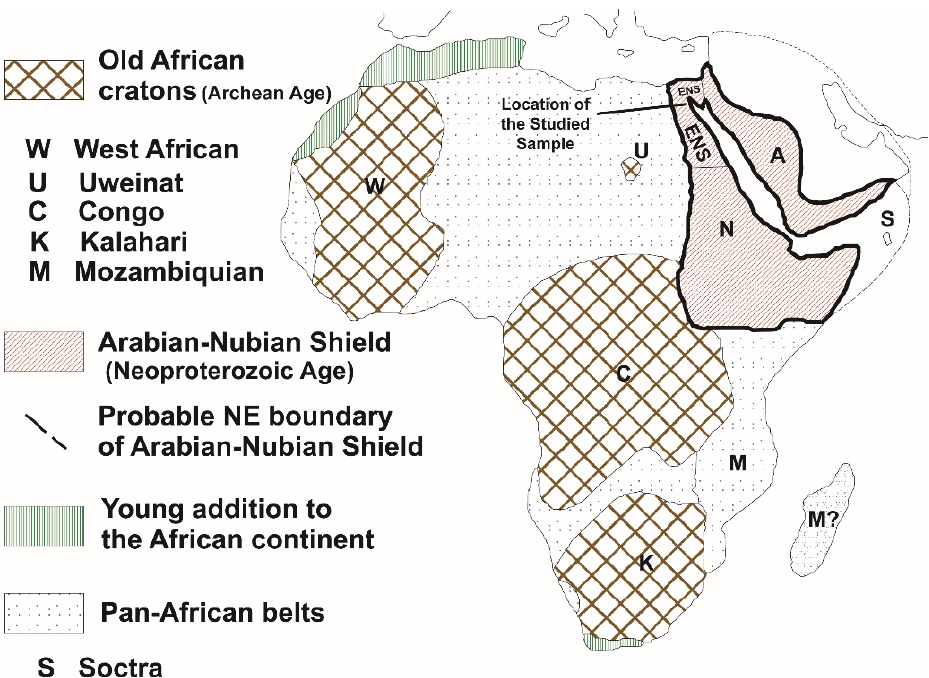
Figure 1. Location map for the ANS (the ENS; the Egyptian part of the Nubian Shield) in the frame of the African continent, and the studied sample (modified after [33,34]).